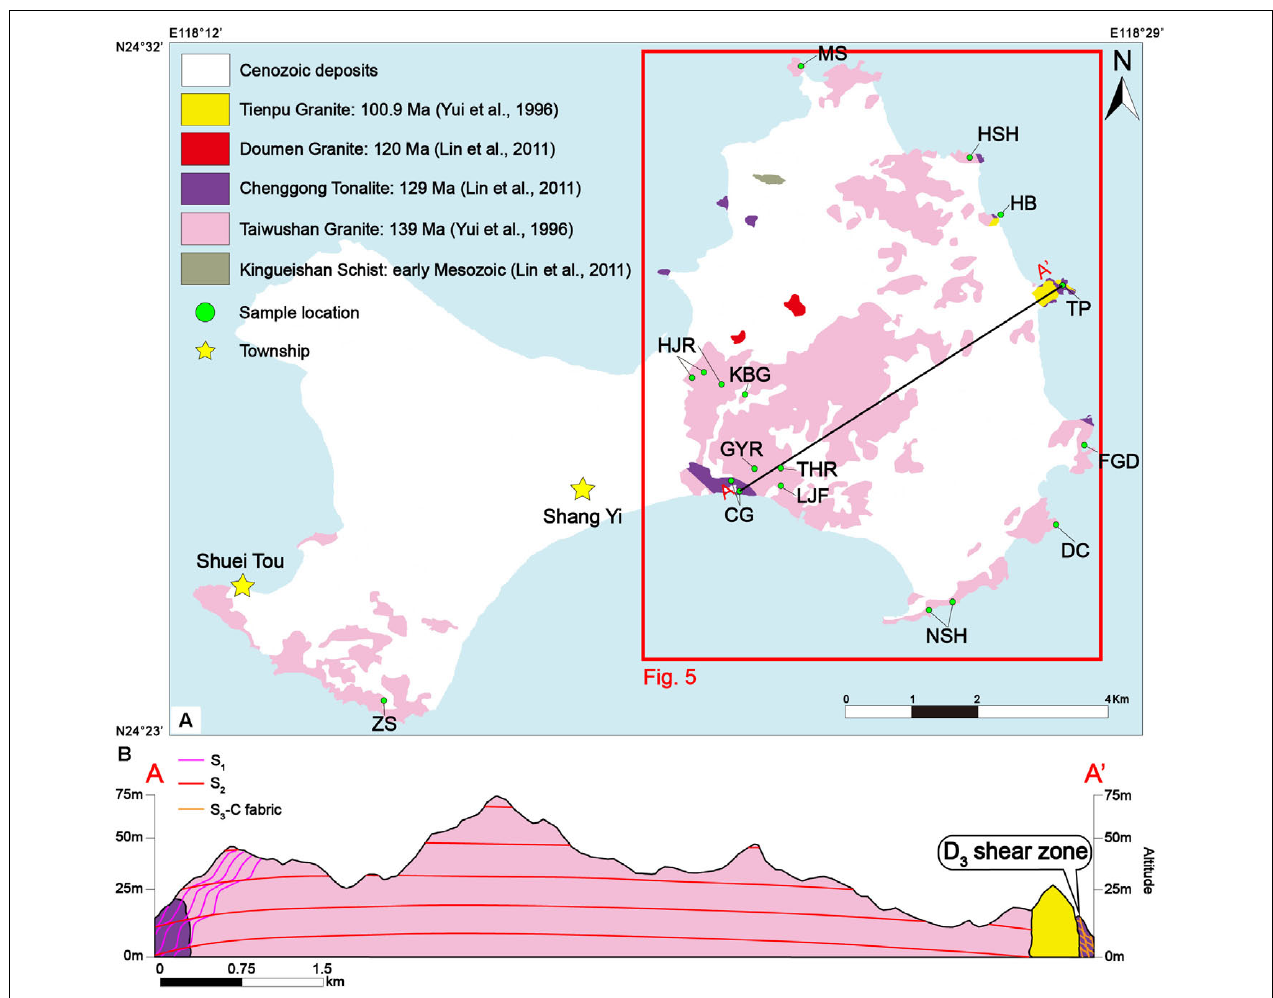
FIGURE 2 | Geological map of the Kinmen Island showing the distribution of Cretaceous magmatism and sample locations. (A) Geological map modified from Lin et al. (2011). (B) Schematic diagram of reconstructed A-A’ cross section. The pink line indicates the gneissic foliation (S 1 ) defining the D 1 doming event. The red line indicates the subhorizontal S-tectonite (S 2 ) of D 2 . The orange line indicates the locally developed D 3 shear belts (S/C